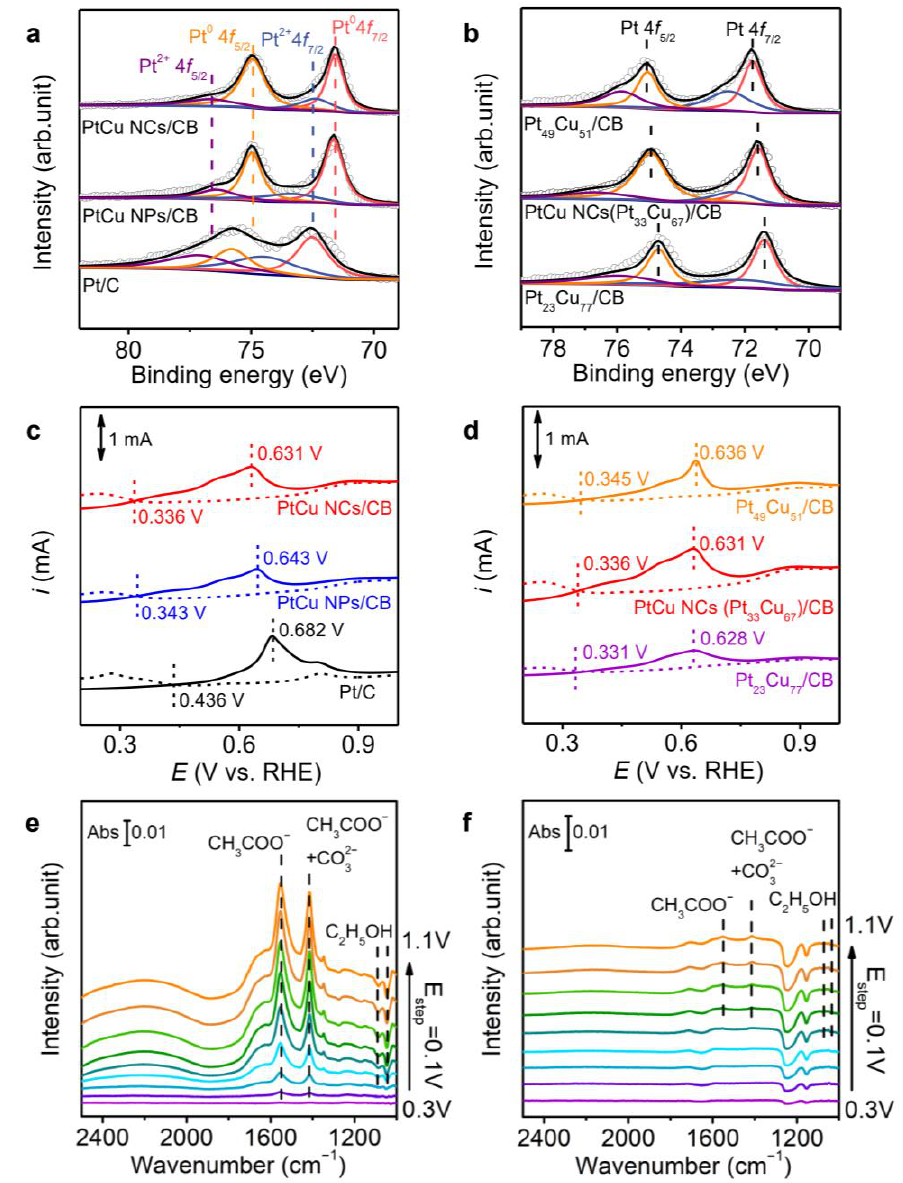
Figure 3. Electronic structures and electrochemical properties of Pt-based catalysts. ( a ) Pt 4 f XPS spectra of PtCu NCs/CB, PtCu NPs/CB, and Pt/C. ( b ) Pt 4 f XPS spectra of Pt 49 Cu 51 /CB, PtCu NCs (Pt 33 Cu 67 )/CB, and Pt 23 Cu 77 /CB. ( c ) CO-stripping experiments for PtCu NCs/CB, PtCu NPs/CB, and Pt/C in 1.0 M KOH. ( d ) CO-stripping experiments for Pt 49 Cu 51 /CB, PtCu NCs (Pt 33 Cu 67 )/CB, and Pt 23 Cu 77 /CB in 1.0 M KOH. ( e , f ) In situ FTIR of EOR on ( e ) PtCu NCs/CB and ( f ) Pt/C in the mixture of 1.0 M KOH and 1.0 M C 2 H 5 OH at different potentials varying from 0.3 to 1.1 V vs. RHE with an interval of 0.1 V.